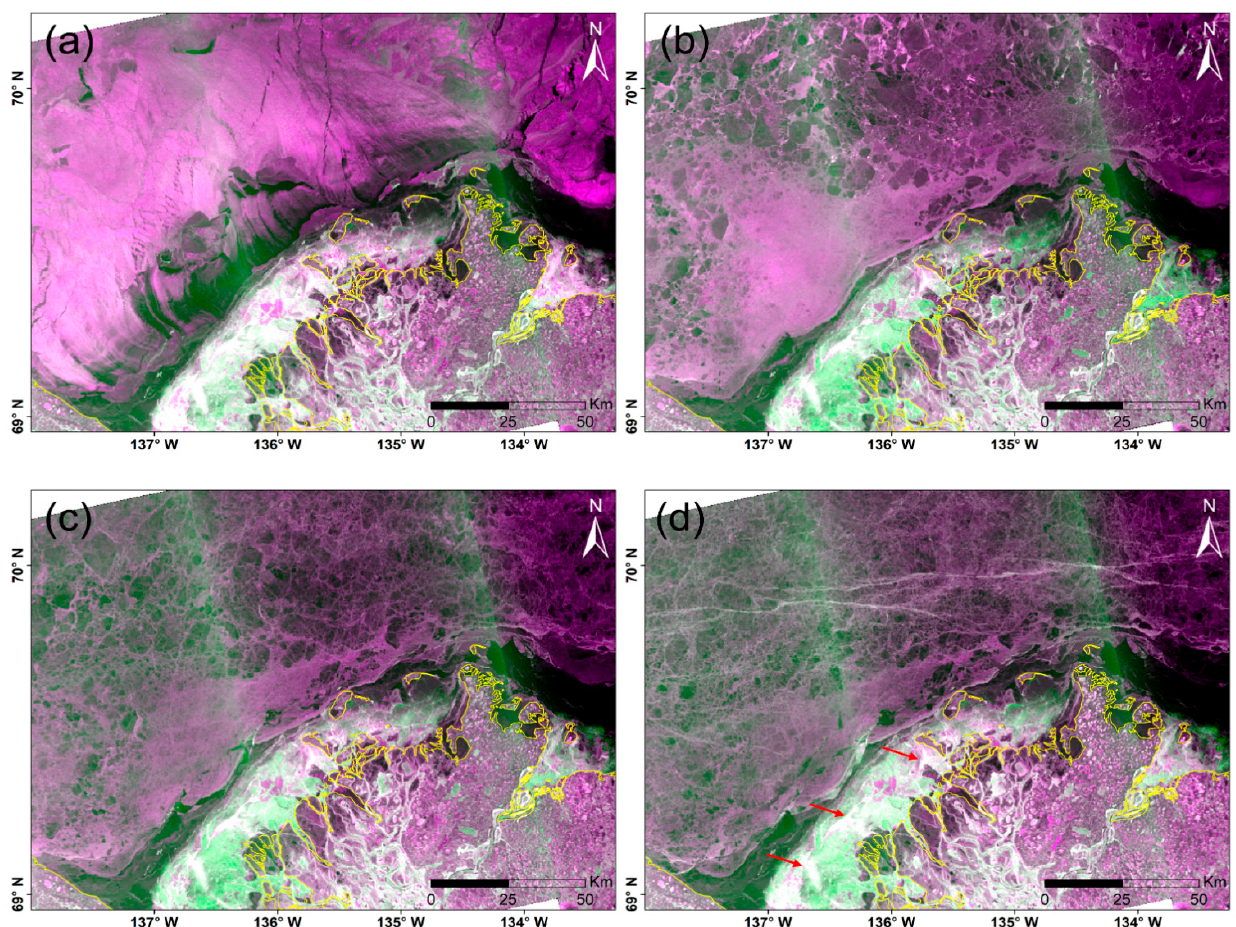
Figure 9. Polarimetric SAR backscatter composite (red: VV, green: VH, blue: VV). ( a ) 20180113. ( b ) 20180125. ( c ) 20180206. ( d ) 20180302. The backscattering coefficients (sigma naught) were linearly stretched between − 25 and − 10 dB for the VV channel and between − 28 and − 18 dB for the VH channel. The red arrows in Figure 8d indicate bright white areas in LFI showing higher VV and VH signals. The coastline is shown in yellow.